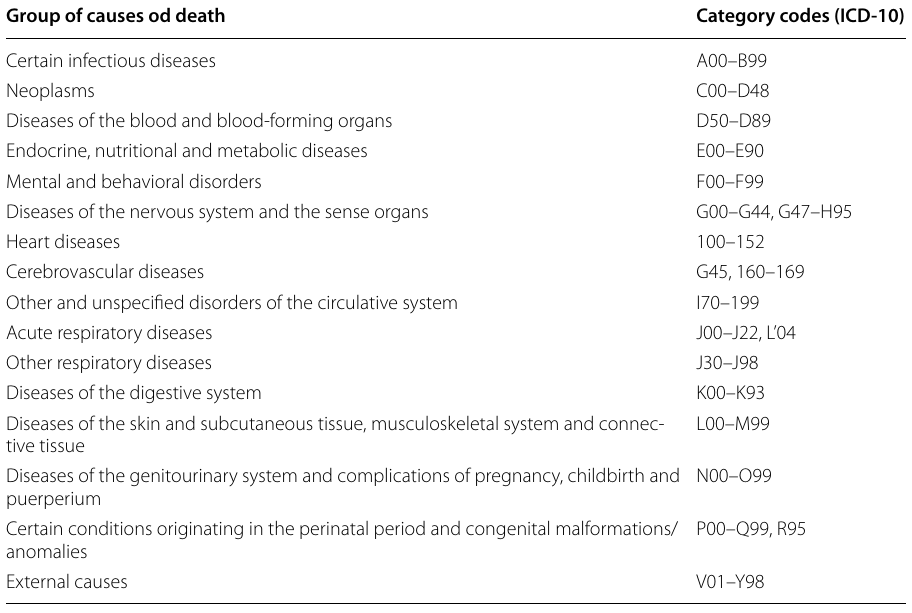
Table 2 Classes of causes of death with related International Classification of Diseases codes according to the 10th revision